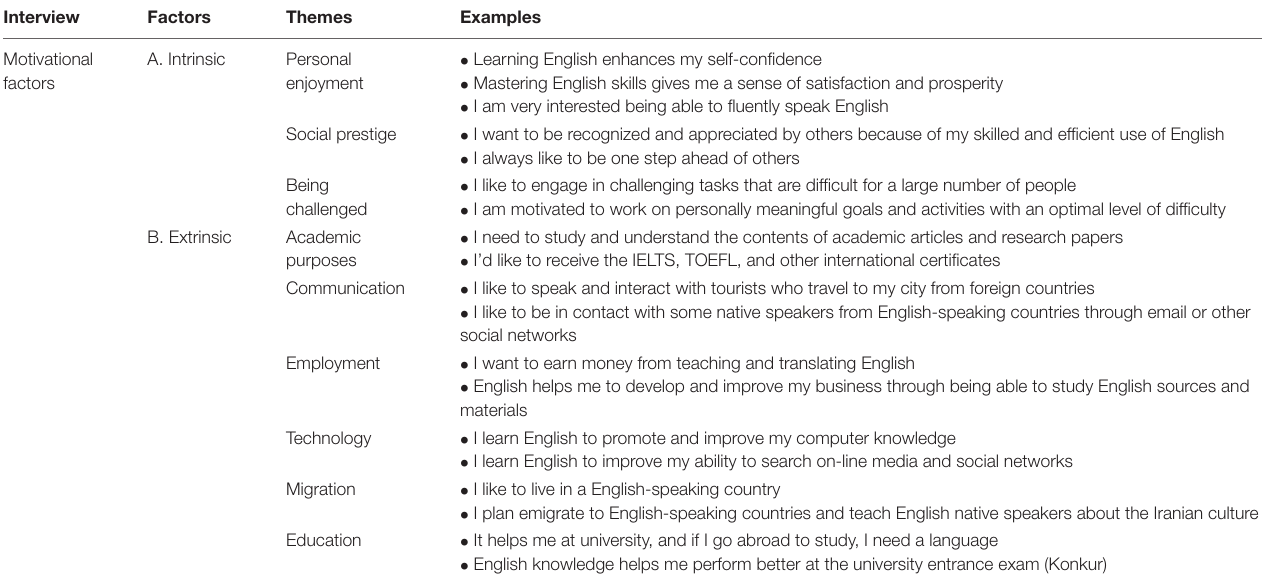
TABLE 4 | Participants’ description of motivational factors in learning